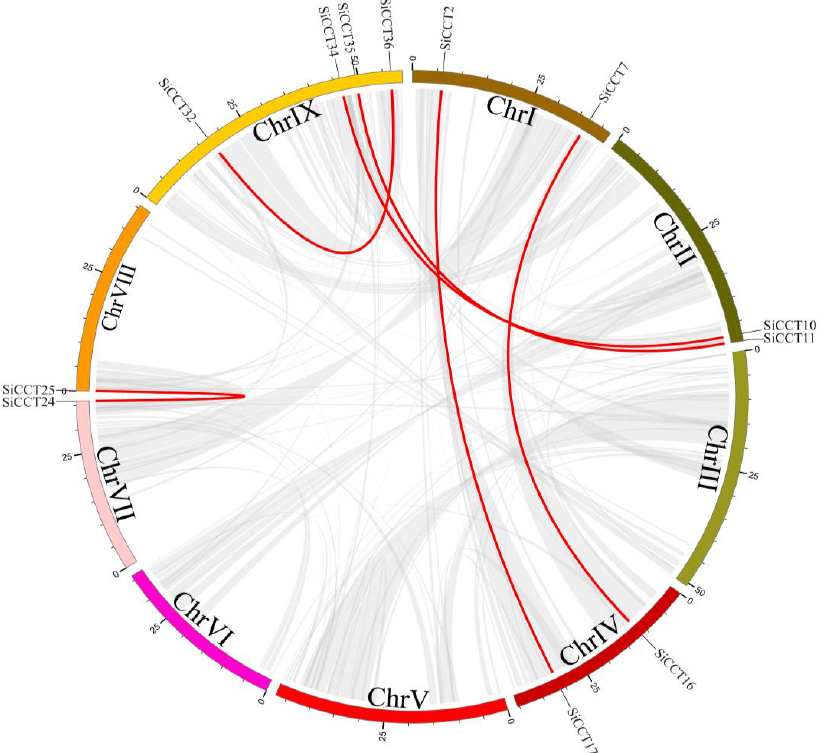
Figure 4. Interchromosomal relationships of millet CCT genes. Gray lines represent all common blocks in the millet genome, and red lines represent replicated CCT gene pairs. Table 2. Evolutionary analysis of SiCCT genes.